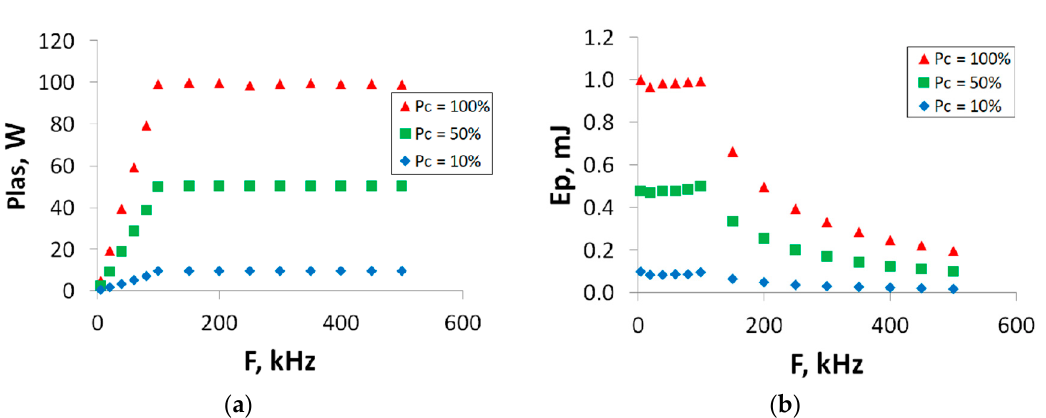
Figure 1. Graphs of dependencies of ( a ) the measured power and ( b ) the calculated pulse energy on frequency at various values of the power factor.